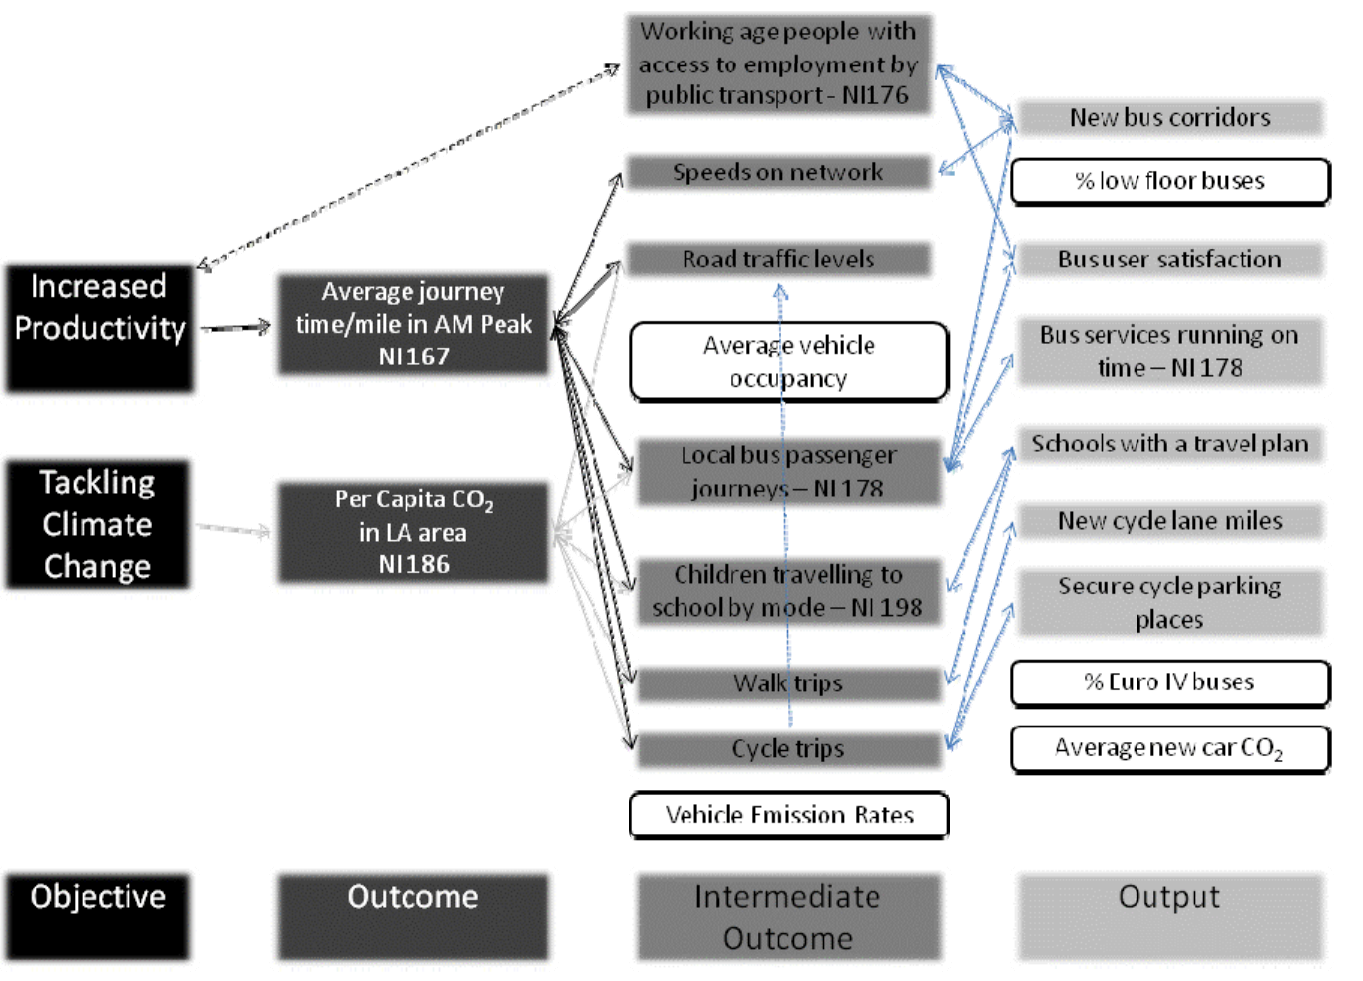
Figure 3. Prioritised indicator